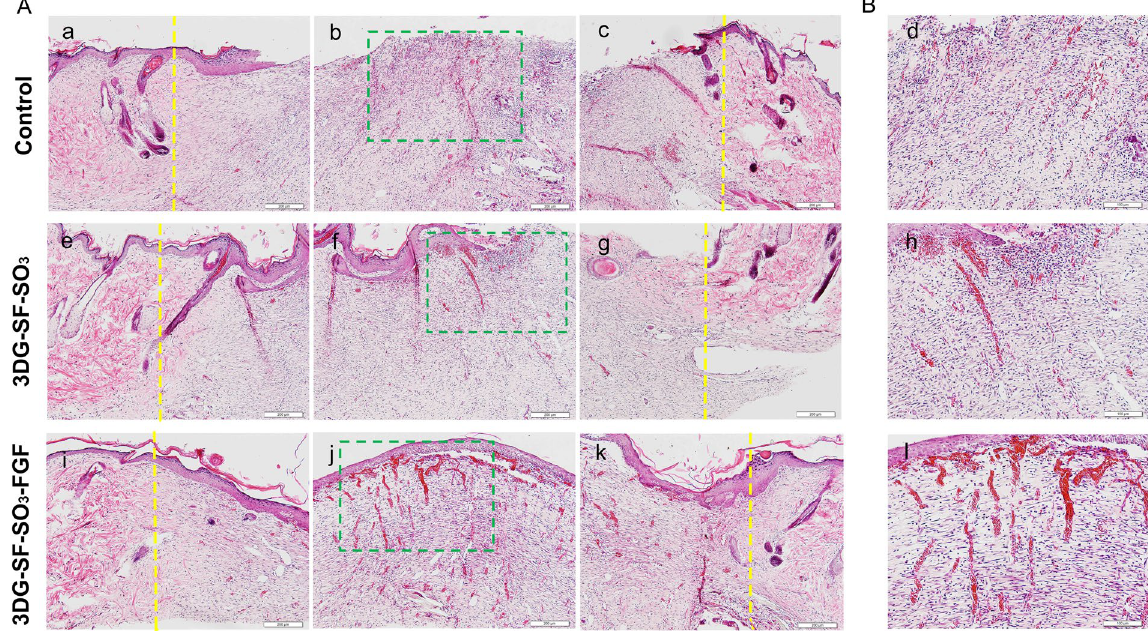
Figure 5. Representative H&E staining of skin tissue sections at 14 days post-surgery. which illustrate the healing process at the left (a,e,i), centre (b,f,j) and right regions of the wound (c,g,k). Yellow lines in the images indicated the boundaries between the wound and the surrounding normal skin. ( B ) Magnified view (d,h,l) of the regions in green pane in figure ( A ) (b,f and j). Scale bars = 200 μ m ( A ), and 100 μ m ( B ) respectively.